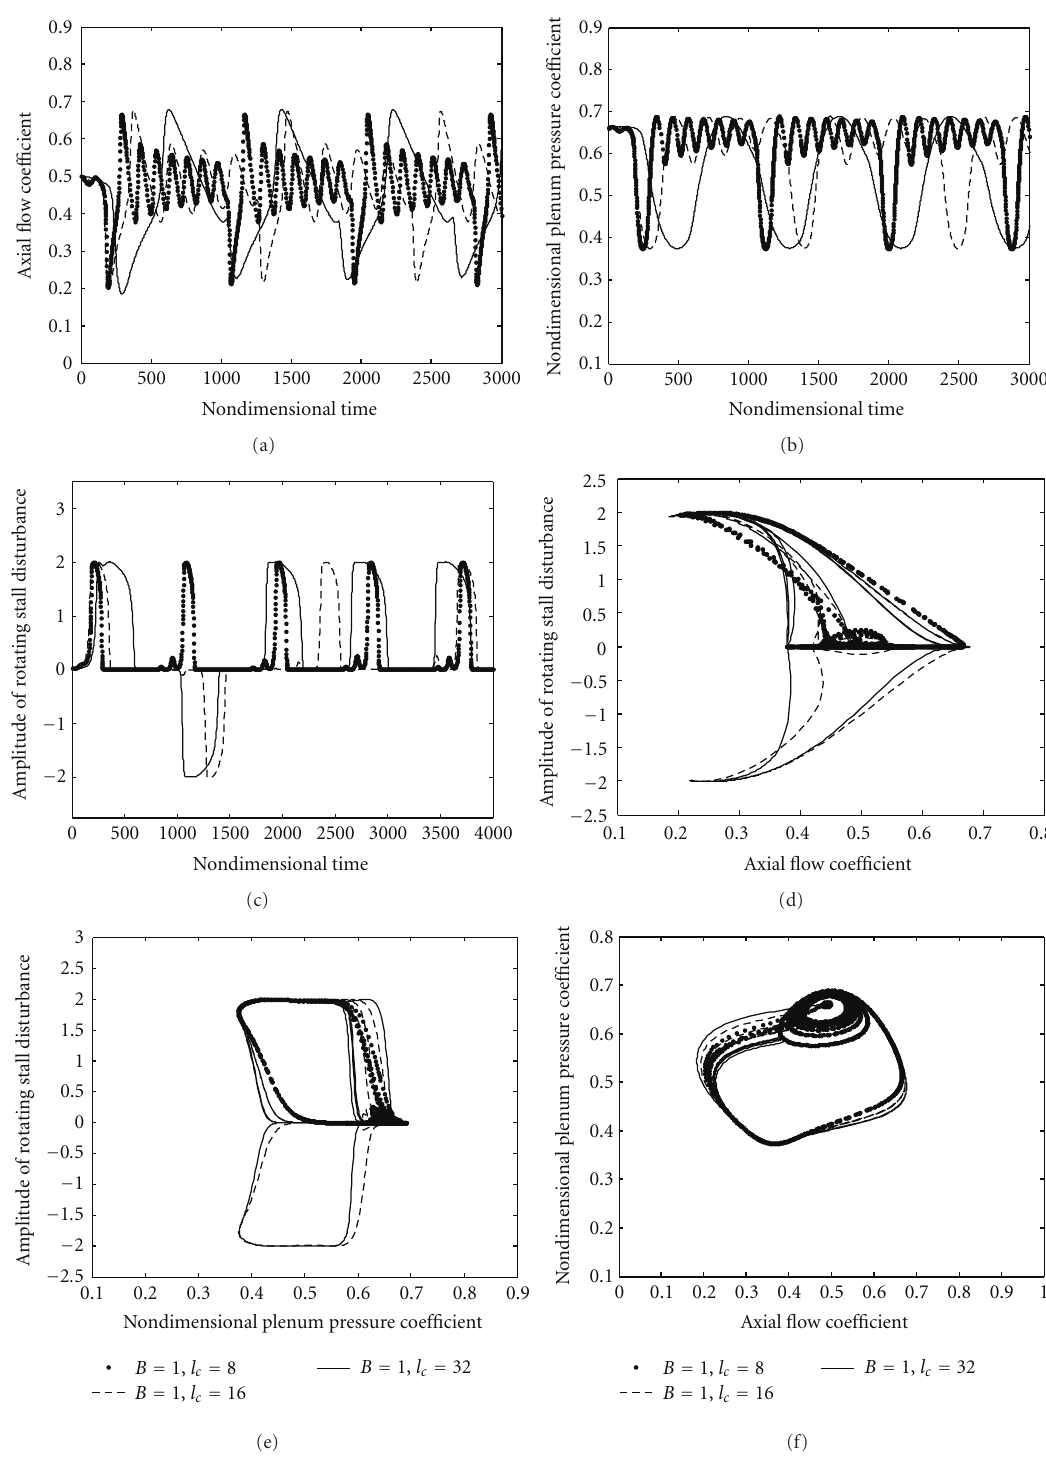
Figure 10: E ff ect of decrease in mean annulus area of compressor: variation of nondimensional flow properties (a), (b), and (c) with time. (a) Axial flow coe ffi cient, (b) plenum pressure rise coe ffi cient, and (c) disturbance amplitude of rotating stall. (d) Variation of axial flow coe ffi cient with disturbance amplitude of rotating stall. (e) Variation of plenum pressure rise coe ffi cient with disturbance amplitude of rotating stall. (f) Limit cycle oscillation: axial flow coe ffi cient versus plenum pressure rise coe ffi